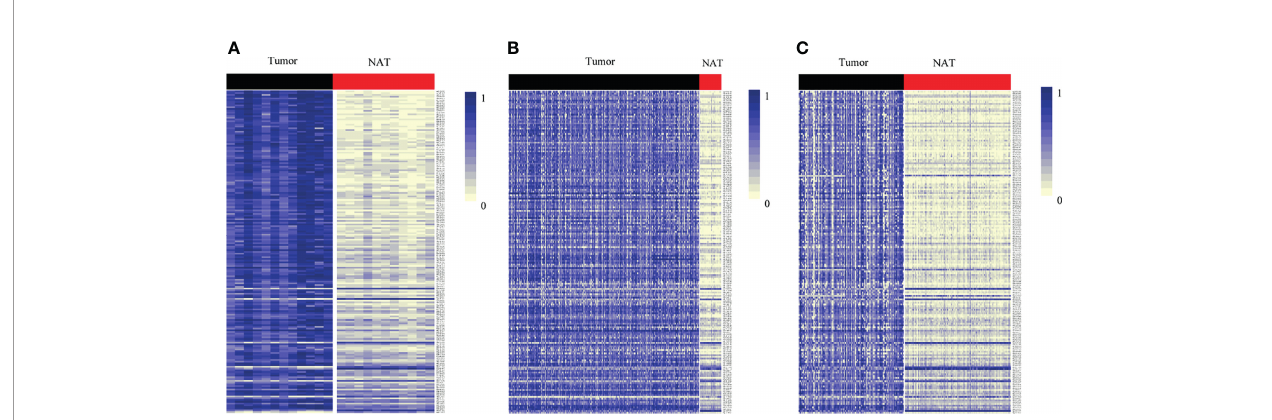
FIGURE 2 | Heat map showing differentially methylated CpG sites mapping to the promoter of lncRNAs between lesion tissues and paired adjacent normal tissues from genome-wide pro fi ling. Methylation pro fi ling using (A) 850K array of our dataset. (B) 450K array from TCGA dataset. (C) 450K array from GEO dataset. Each column represents a sample. Each row represents the methylation level of an individual CpG sites, which is depicted as a color gradient ranging from light yellow (completely nonmethylated) to blue (fully methylated). NAT, histologically normal tissue adjacent to the